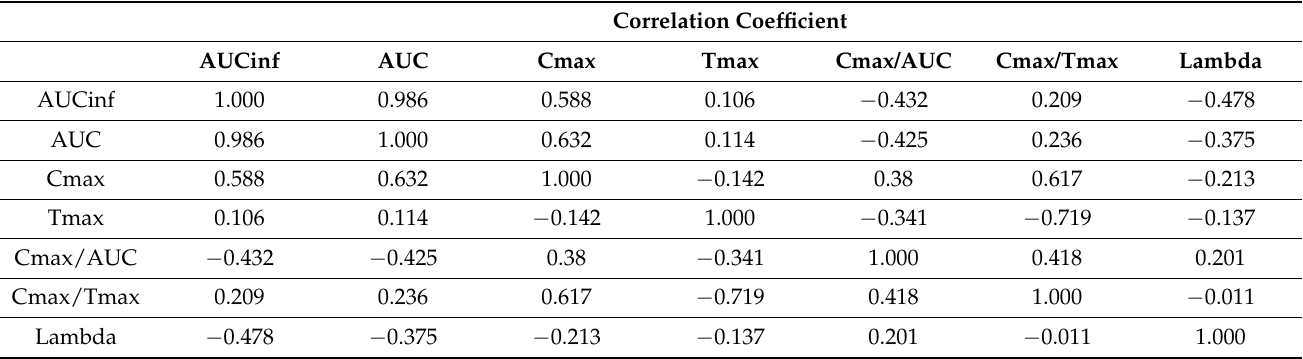
Table 1. Pearson correlation coefficients for the bivariate relationships between the pharmacokinetic parameter estimates of the actual donepezil bioequivalence study. Correlation